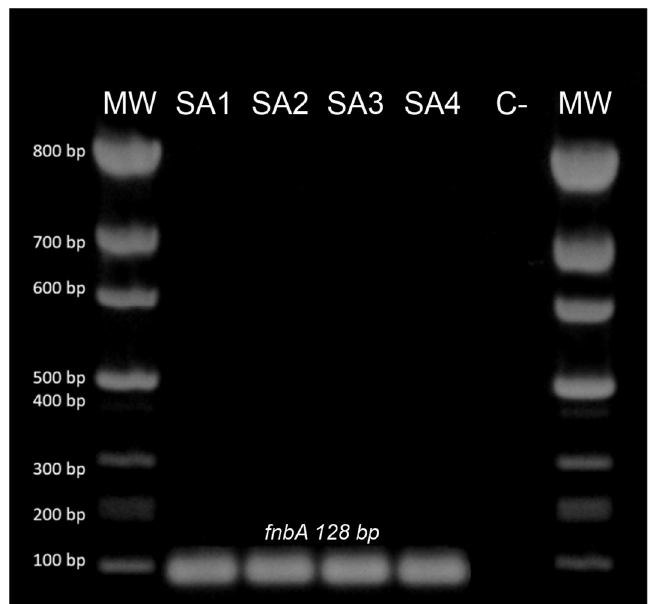
Figure 2. Exemple result of fnb A (128 bp) for the detection of the S. aureus gene. Legend: M—DNA marker (A&A Biotechnology); SA1, SA13, SA31—examined S. aureus isolates from bovine mastitis; C—negative control (DNAse-free water); bp—base pair.